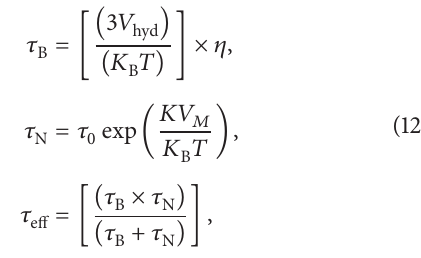
carriers of drugs owing to their biocompatibility and suitable magnetic properties